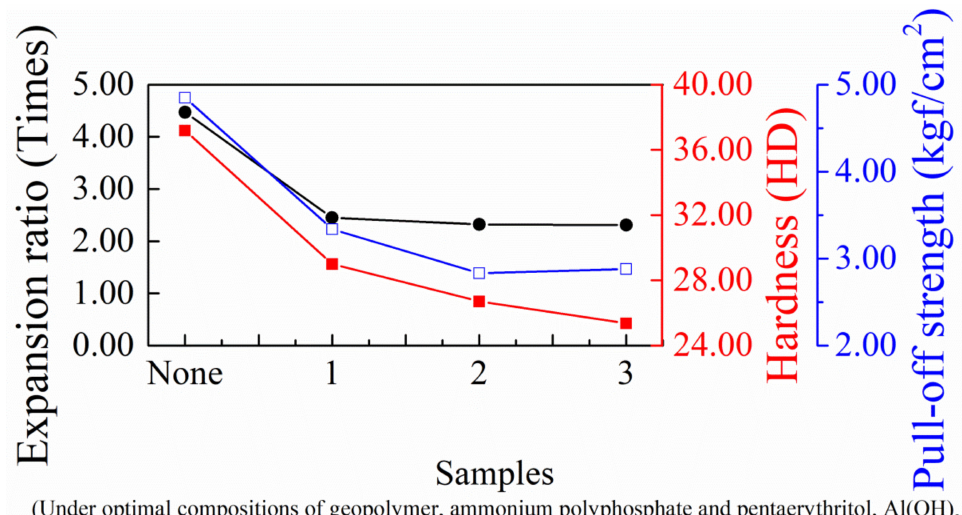
Figure 11. Physical properties of intumescent flame-resistant coatings after thermal heating with optimal ratio of sodium silicate, ammonium polyphosphate, pentaerythritol and various contents of expandable